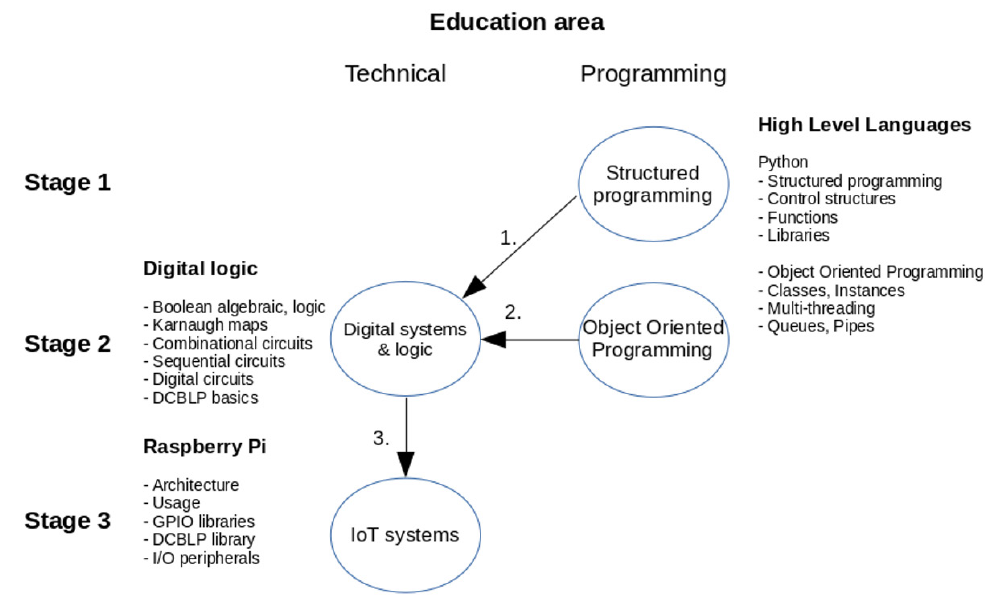
Figure 1. Roadmap used for digital logic and IoT